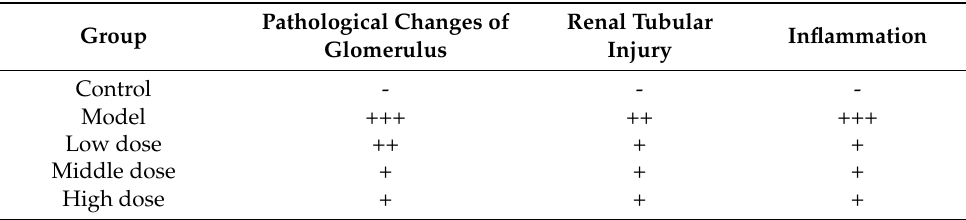
Table 2. Grading of histopathological changes in kidney.